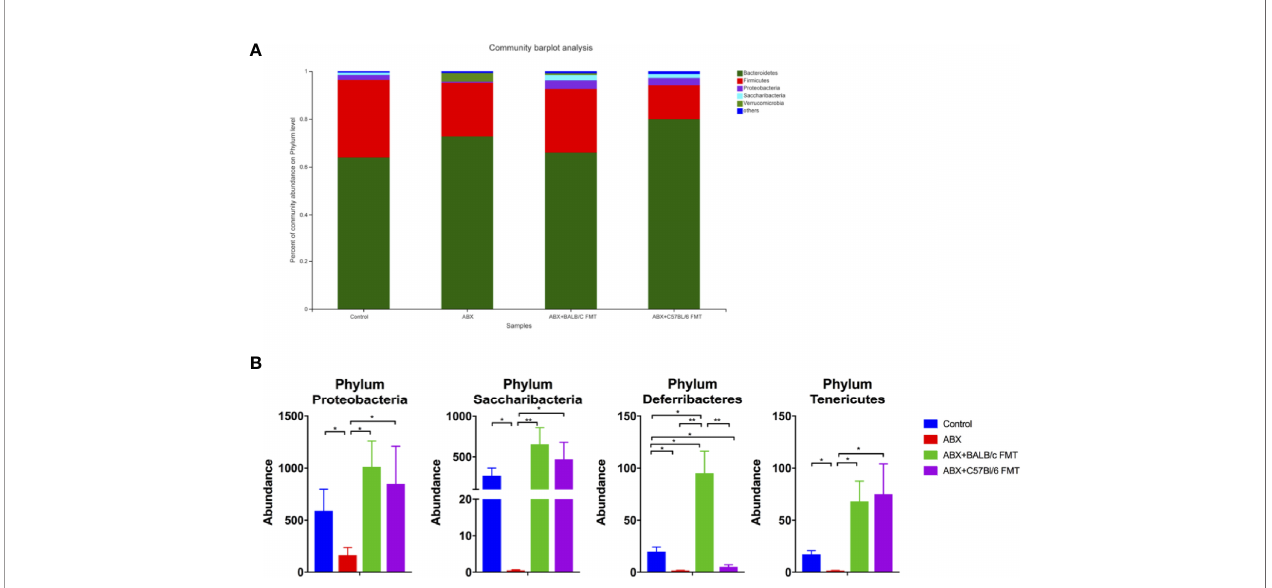
FIGURE 5 | Comparison of the gut microbiota composition at the phylum level after FMT. Gut microbiota composition at the phylum level (A) and abundances of individual bacteria (B) after FMT (on day 35 as indicated in Figure 3A ). n = 4 in control group. n = 5 in ABX, ABX+BALB/c FMT, ABX+C57BL/6 groups. * P < 0.05. ** P < 0.01.